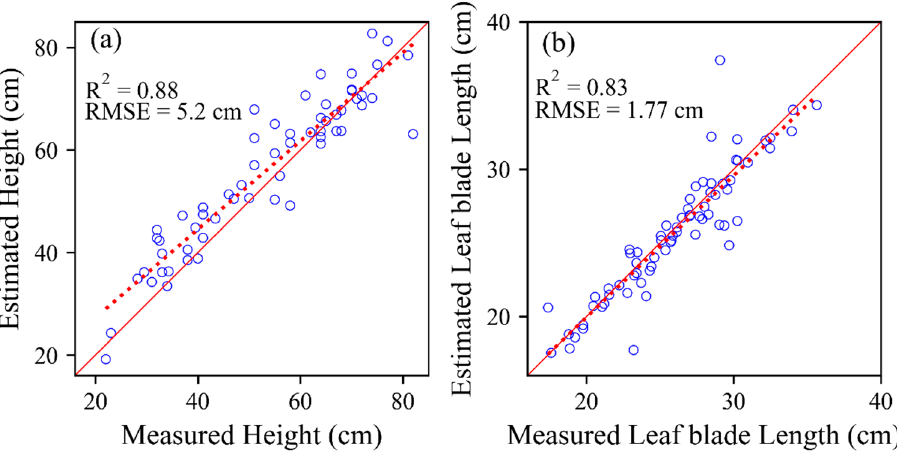
Figure 9. Comparison of the estimated sugar beet height ( a ) and the estimated individual leaf length